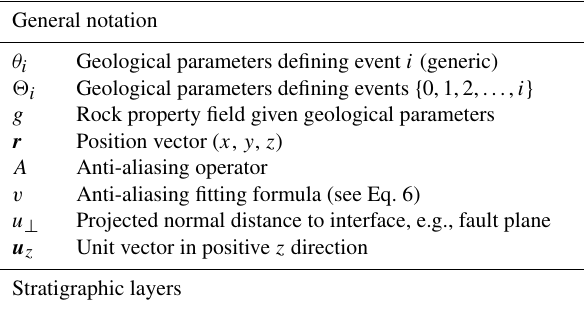
Table 1. Table of symbols for kinematic event notation. General